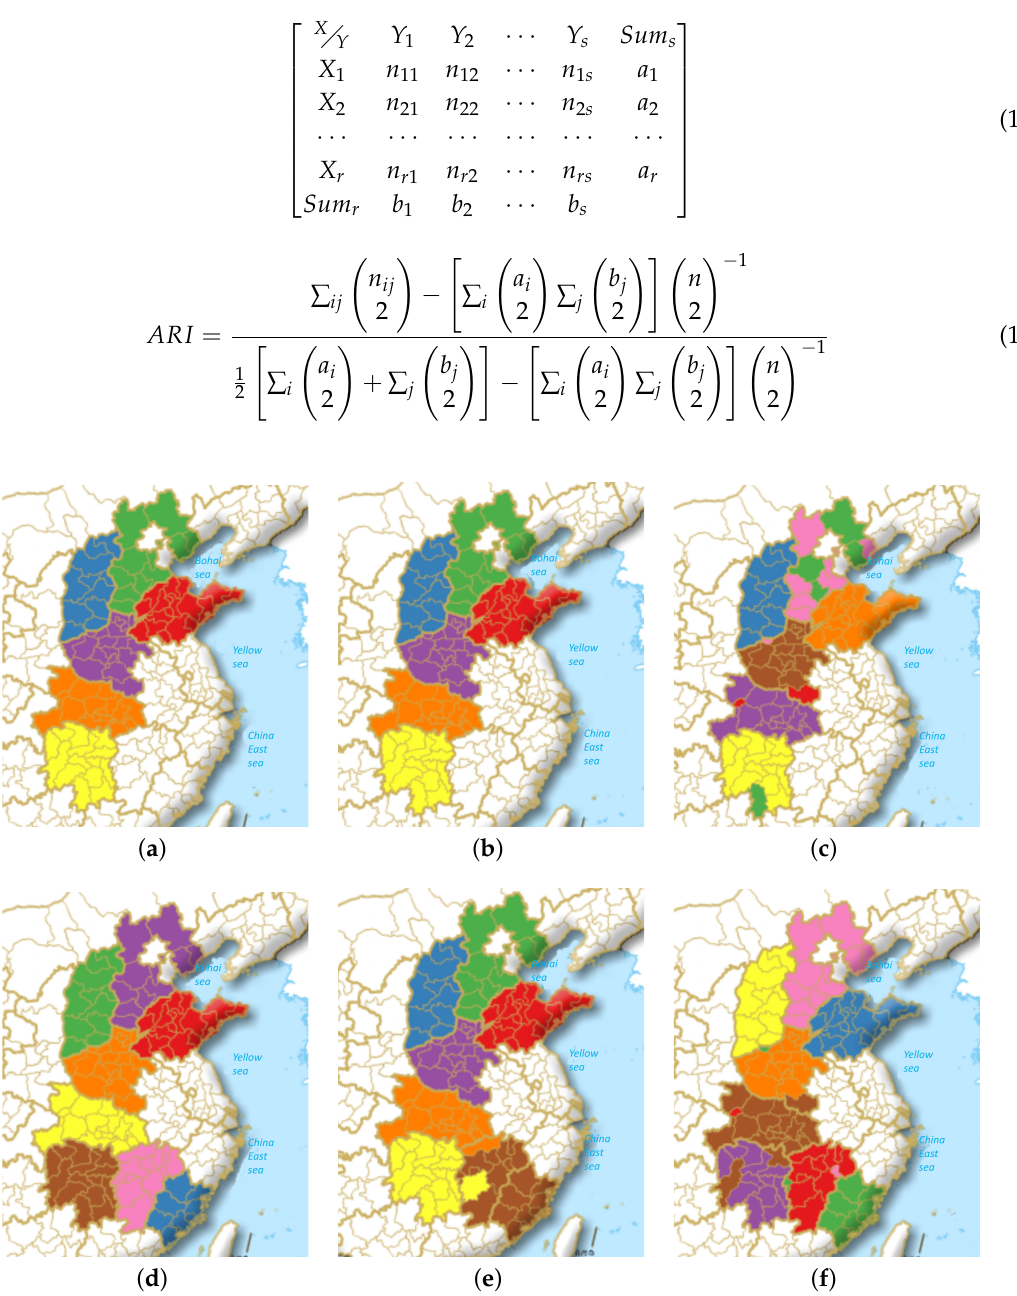
Figure 5. The different divisions displayed geographically. The same color means that these city nodes are assigned to the same class: ( a , d ) city divisions; ( b , e ) the community detection result; and ( c , f ) the calculation result of the MDND model. ( a – c ) The analysis results of Network 2; and ( d – f ) the analysis results of Network 3. These figures are in the form of maps. The cities are drawn in the same color in each figure if they are in the same class. It can be seen that there is little difference between any two of the three